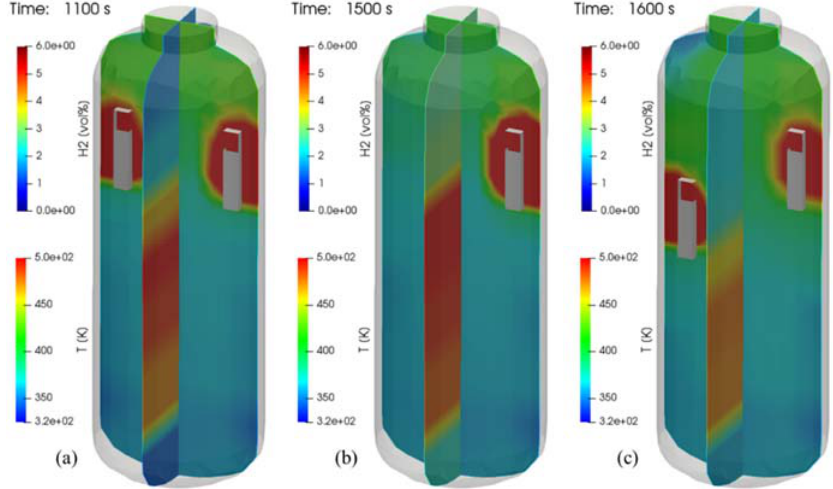
Figure 26. Contours of hydrogen and temperature at 500 s after end of hydrogen injection (temperature contours on a plane crossing the PARs), ( a ) SP1 test, ( b ) SP3 test, and ( c ) SP5 test.